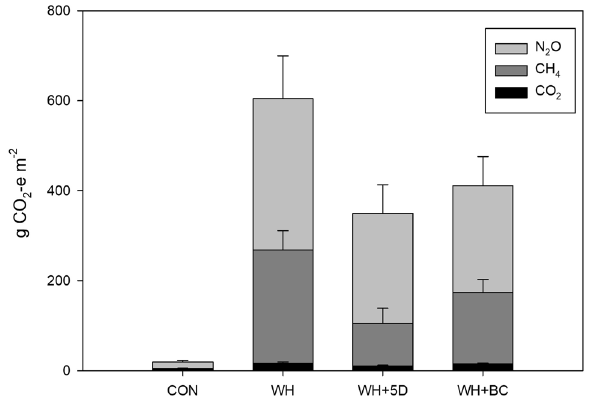
Figure 8. The GWP (g CO 2 -e m −2 soil) from different amendments during BSD treatment period. CON: soil without any amendments; WH: soil amended with wheat straw; WH + 5D: soil amended with wheat straw 5 days before the BSD treatment; WH + BC: soil amended with wheat straw and